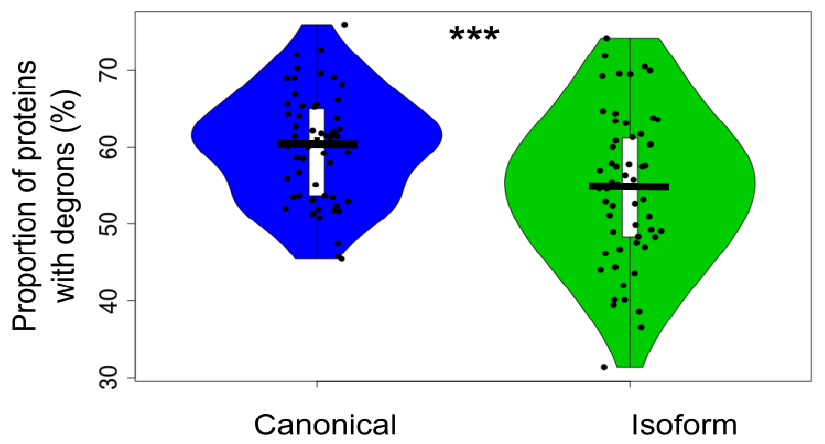
Figure 6. Proportion of canonical proteins and isoforms with degrons predicted by using SLiMs ( t -test p -value = 0.00071). The distributions contain 58 points corresponding to each proteome. The proportion of degron-containing proteins is significantly higher in the canonical set than in the isoform one. Here, *** means significant difference with p -value < 0.001.